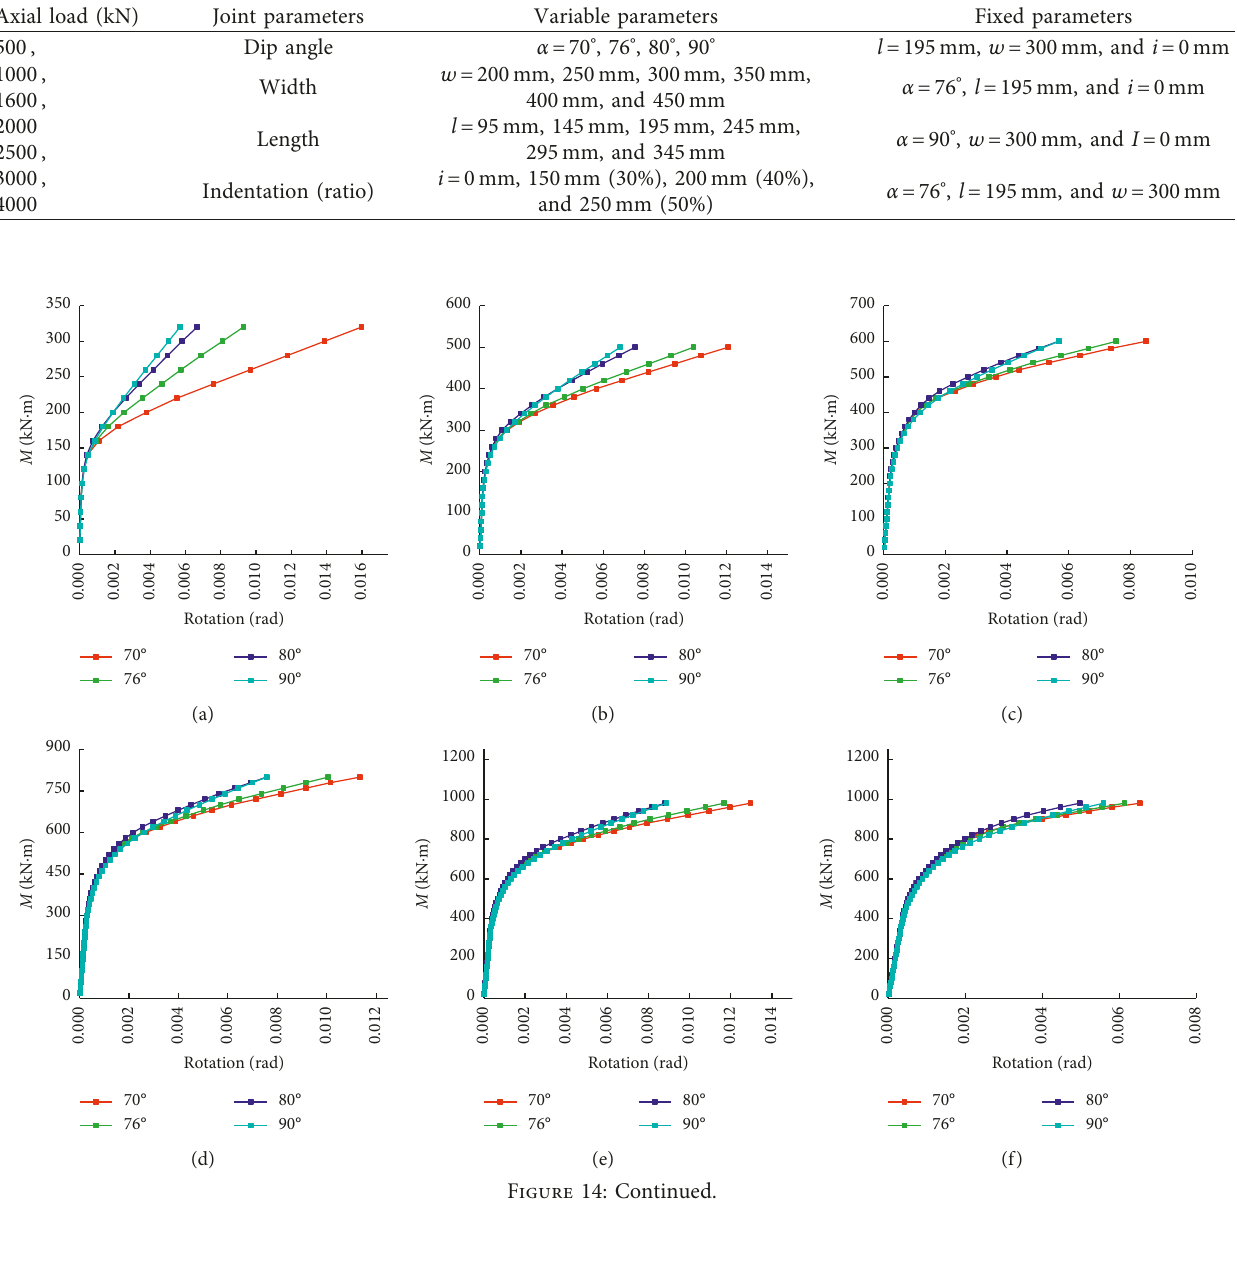
Figure 13: Calculation model for influence analysis of different geometrical parameters. Table 1: Numerical simulation cases.